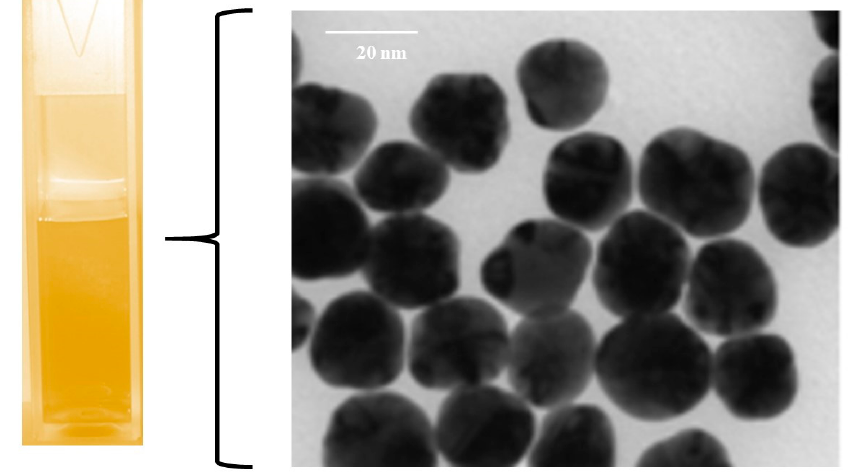
Figure 2. Photograph of uncoated spherical nanoparticles in aqueous suspension ( left ), and Transmission Electron Microscopy (TEM) image of a sample ( right ).